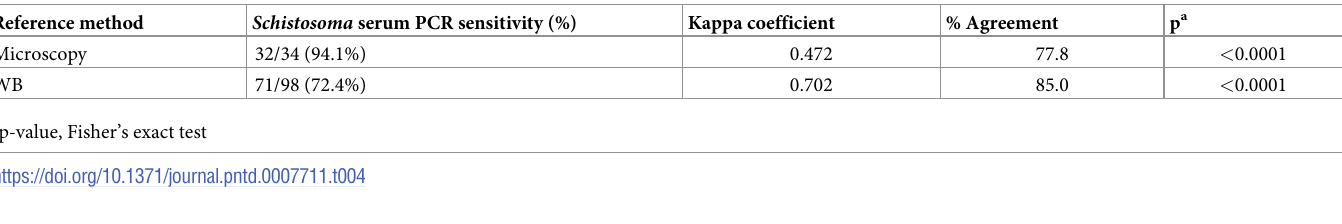
Table 4. Sensitivity and agreement of serum PCR against microscopy and WB-based